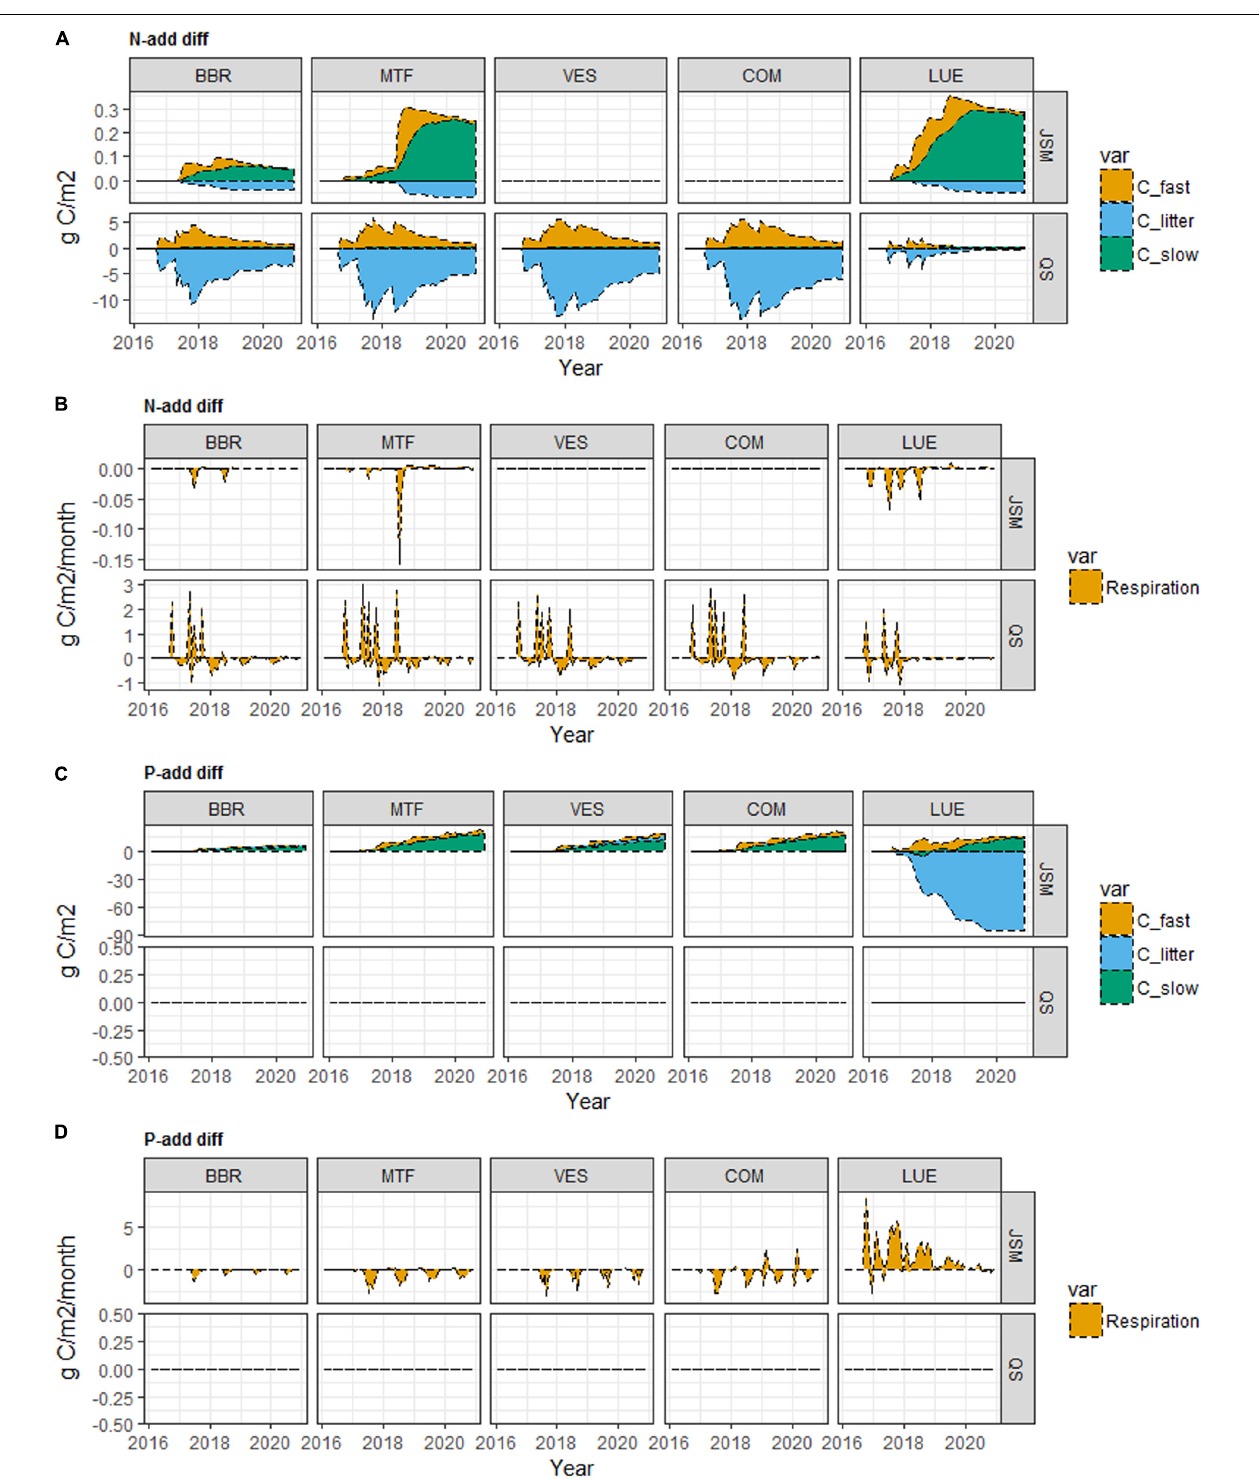
FIGURE 3 | Simulated SOC and soil respiration responses to N addition ( A,B , N-add diff), and P addition ( C,D , P-add diff) of JSM and QUINCY-soil (QS) at the study sites along the soil P gradient (BBR > MTF > VES > COM > LUE). Fast C refers to C in microbe, microbial residue and dissolved organic matter (DOM) pools in JSM, and C in fast SOM pool in QUINCY-soil; slow C refers to C in mineral-associated DOM and mineral-associated residue pools in JSM, and C in slow SOM pool in QUINCY-soil; litter C refers to C in litter in both models. Time for N addition: September 2016; April 2017; June 2017; September 2017; May 2018. Time for P addition: September